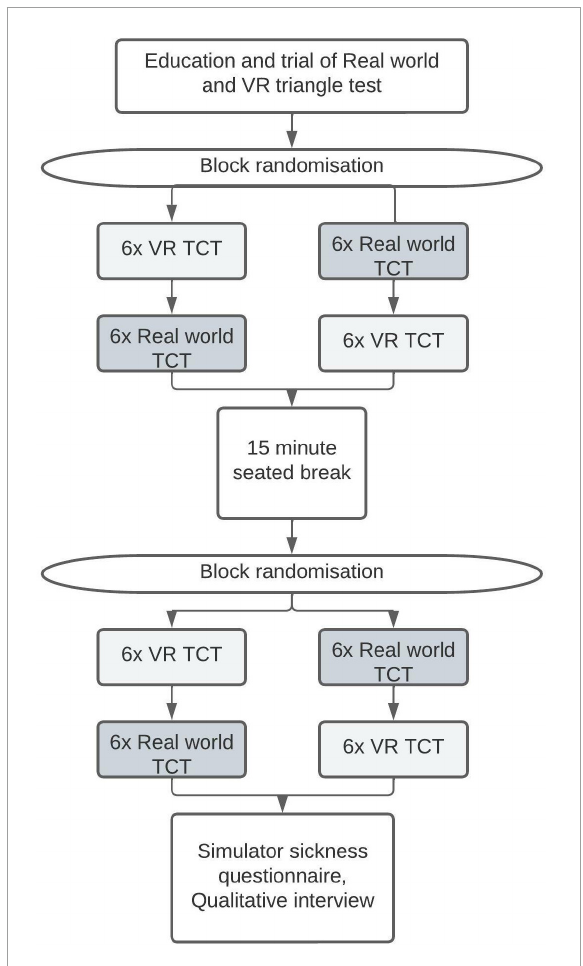
FIGURE1 Flow chart of the study protocol. VR, virtual reality; TCT, triangle completion test.